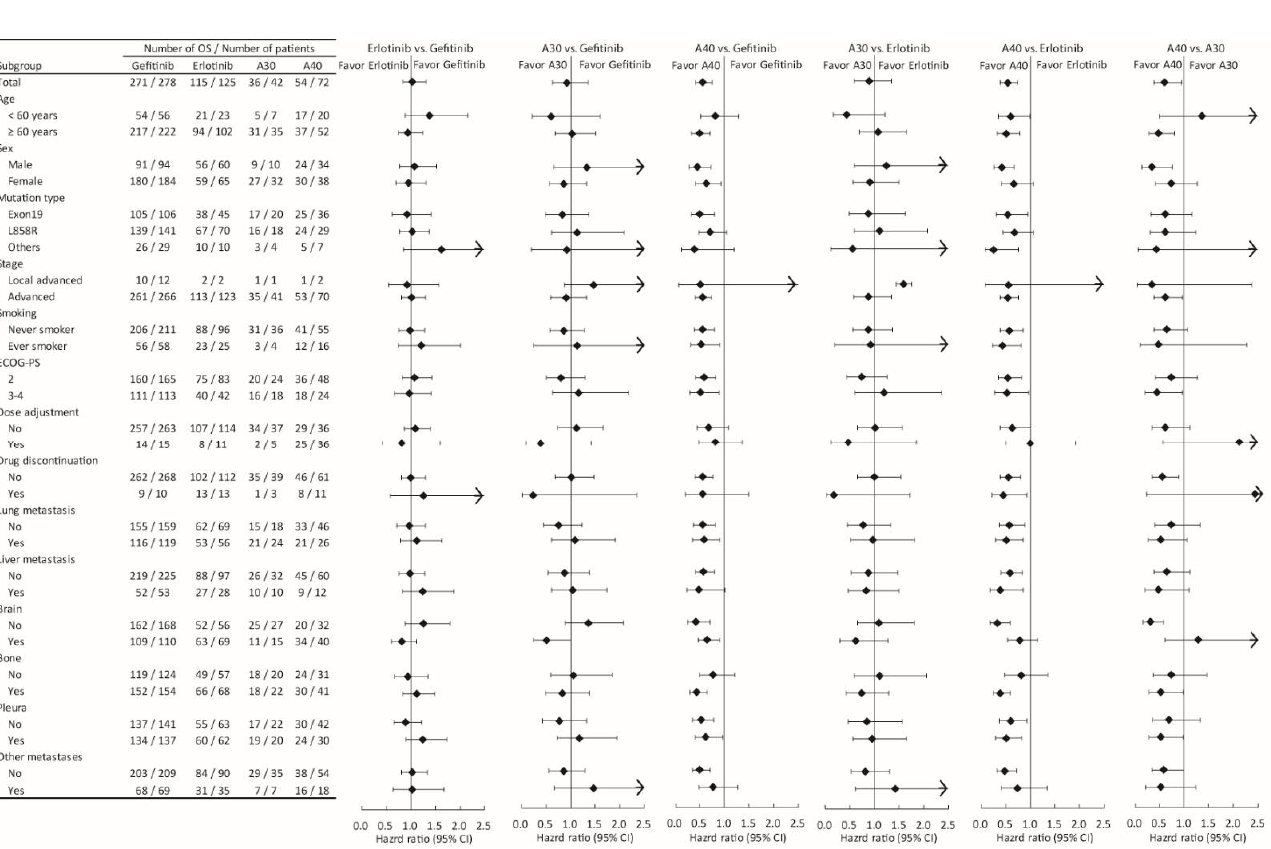
Figure 5. Subgroup analysis comparing overall survival among the different epidermal growth factor receptor tyrosine kinase inhibitors treatments, stratified by selected baseline characteristics.